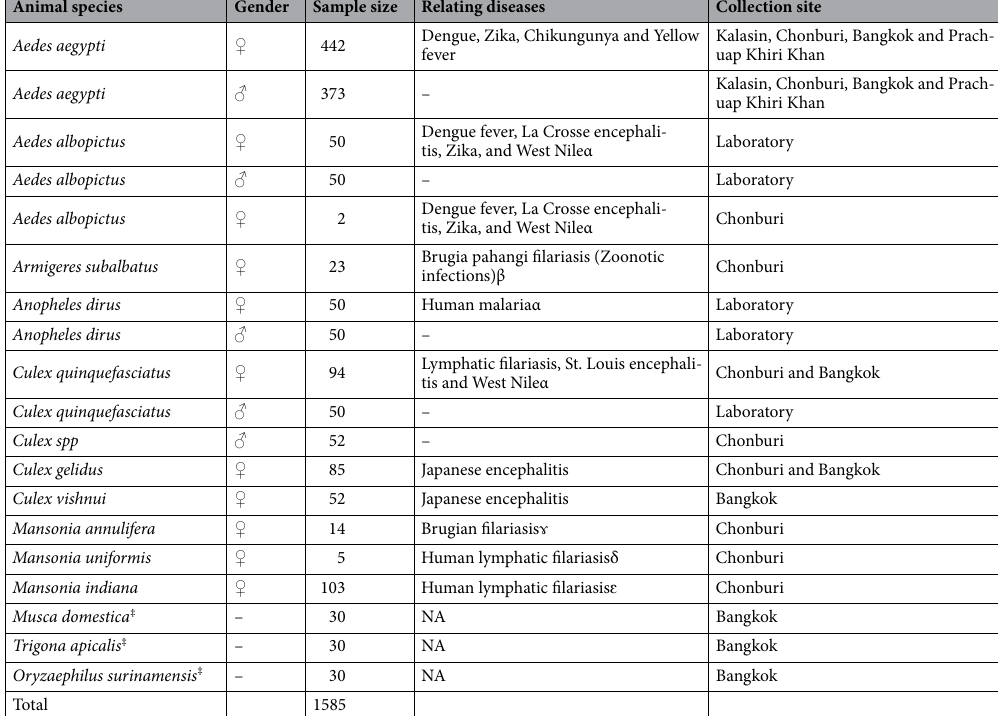
Table 1. Biological samples. ‡